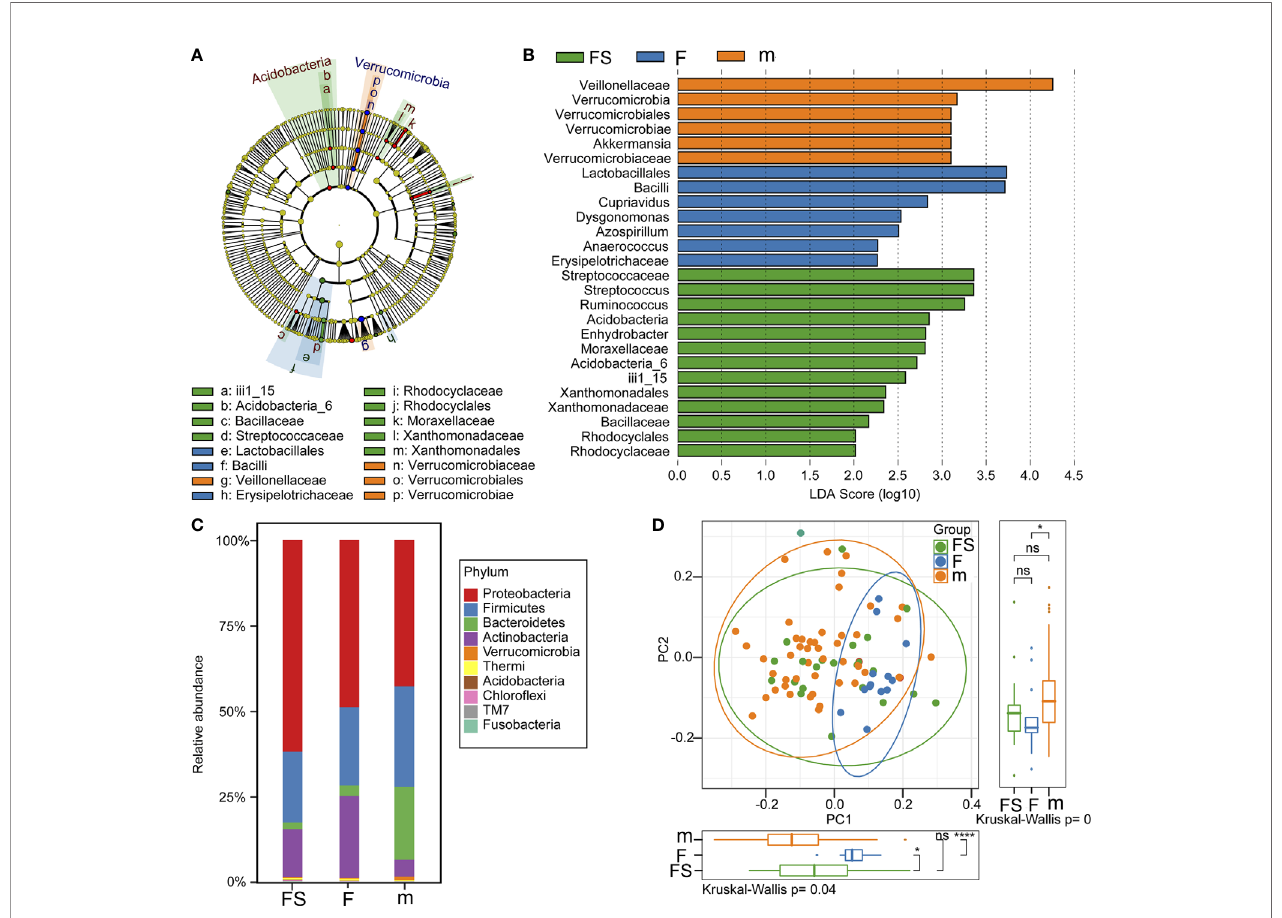
FIGURE 3 | Analysis of gut microbial community structure. (A) A cladogram representation of data in the three groups. (B) LDA differential contribution analysis. (C) Species composition abundance in the three groups. (D) PCoA analysis. fs, supplemented formula group (n = 22); f, standard formula group (n = 13); m, breastfeeding group (n = 48). *(p < 0.05); ****(p < 0.0001); ns, no signi fi